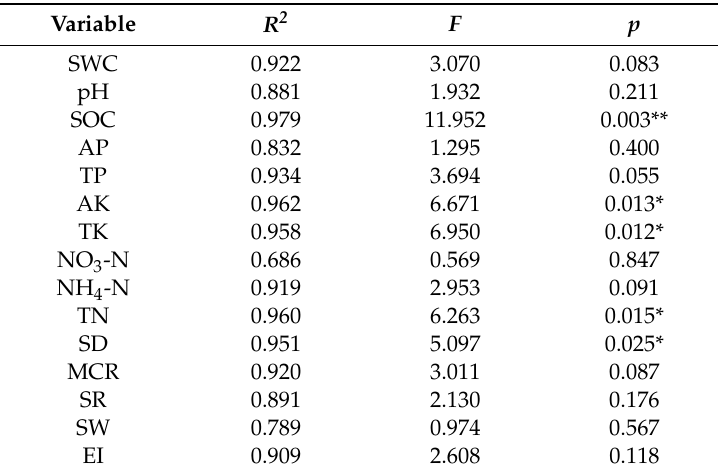
Table 2. Regression analysis of arbuscular mycorrhizal fungal community composition versus soil properties, spore density, mycorrhizal colonization rate, and diversity